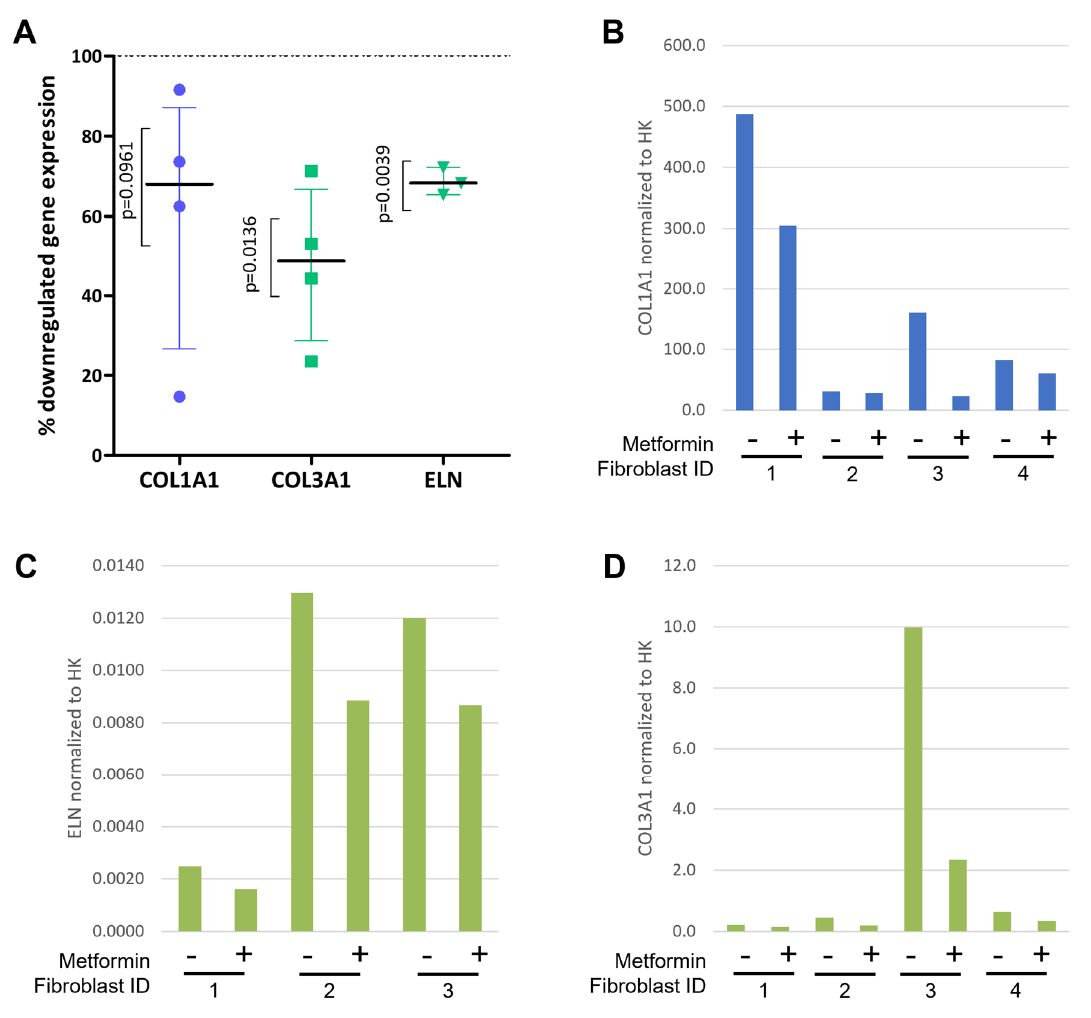
Figure 2. Metformin downregulates TGFB1-induced gene expression in fibroblasts from women with POP. Cells derived from prolapsed tissues from premenopausal women ( n = 4) were stimulated for 24 h with TGFB1 [0.1 ng/mL] and then challenged with Metformin [2 mM] for another 24 h. Real- time PCR was used to measure three TGFB1-regulated genes from the landscape, i.e., the collagen genes COL1A1 and COL3A1 and elastin (ELN) and the two housekeeping genes YWHAZ and HPRT1 . ( A ) shows the percentage (%) of downregulated gene expression in TGFB1-stimulated fibroblasts (with the dotted line corresponding to 100% gene expression in cells treated with TGFB1 [0.1 ng/mL]). One outlier was identified using Grubbs’ test [18] and removed from the ELN gene expression data set (n = 3). ( B – D ) show the expression of COL1A1 , ELN , and COL3A1 in the fibroblasts from each individual woman with POP normalized to the housekeeping genes according to the Pfaffl model [19],